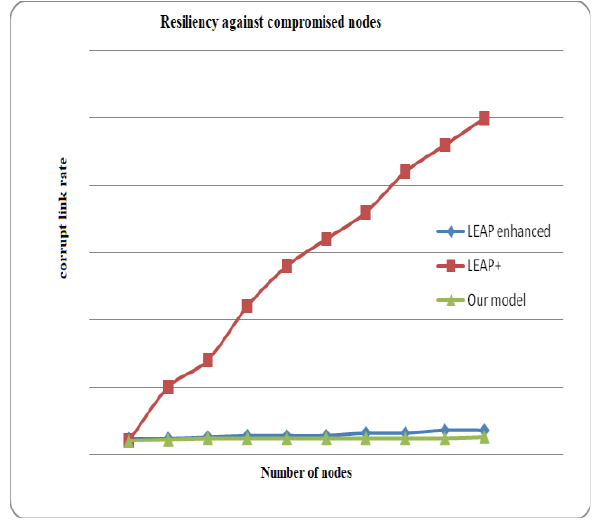
Figure 7 . Resiliency against compromised